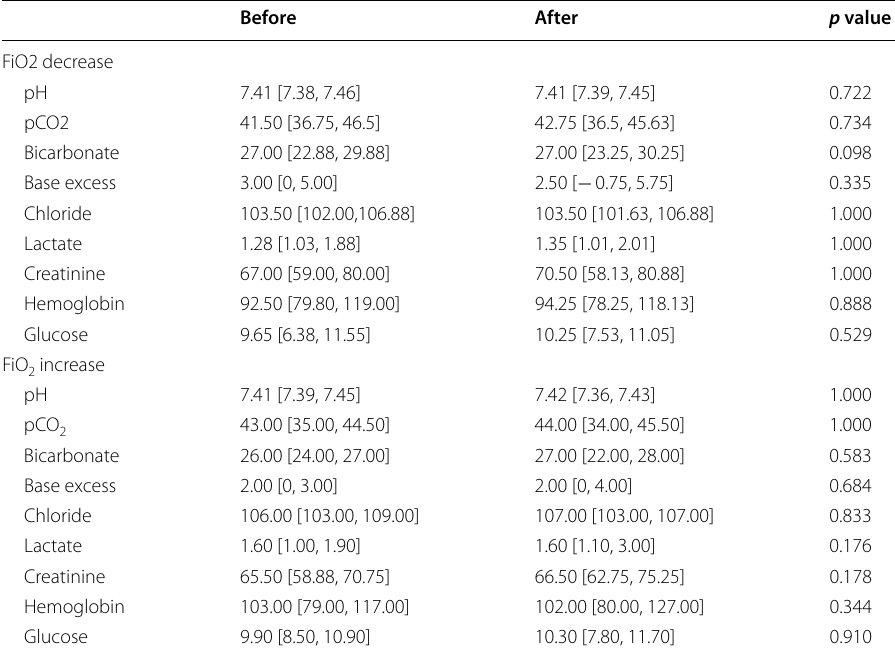
Table 3 Laboratory values before and after FiO2 change in human patients Before After p